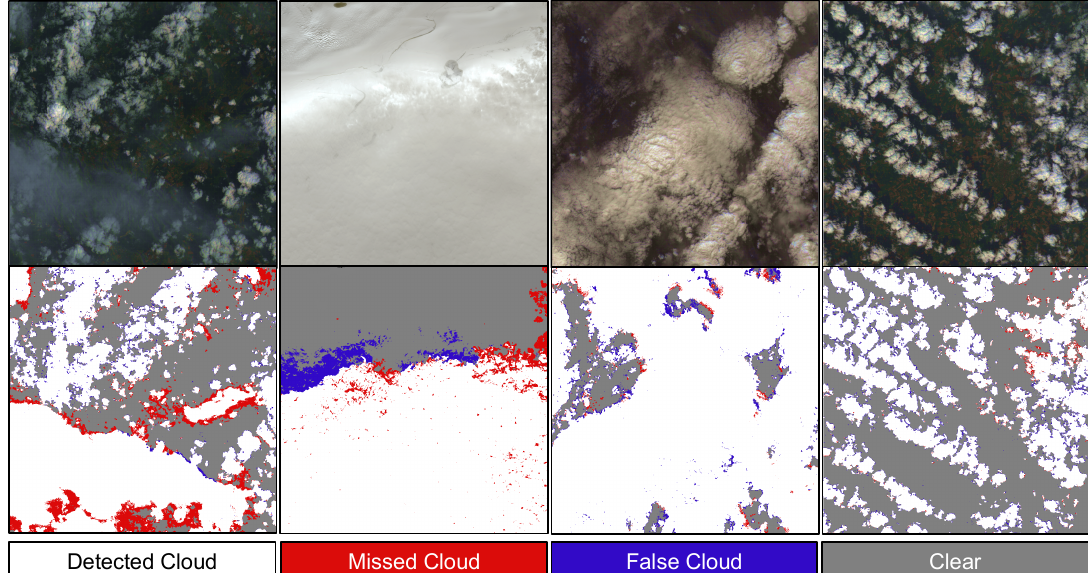
Figure 3. Four examples of cloud detection on the Biome dataset from the multispectral model. Very few mistakes are seen in the clouds’ interiors, but the edges are more error-prone. The first example shows what may be a cirrus cloud over a vegetated region, the boundaries of which show noticeably more errors of omission than neighbouring cumulus clouds. The cloud over snow in the second pane is successfully detected, although large errors are seen at it’s edge. The final two panes show highly successful detections of different kinds of cloud over varied terrain, despite some disagreement at the very edges of clouds, which are often not well defined and rather ambiguous. All scenes are shown as RGB composites using bands 4, 3 and